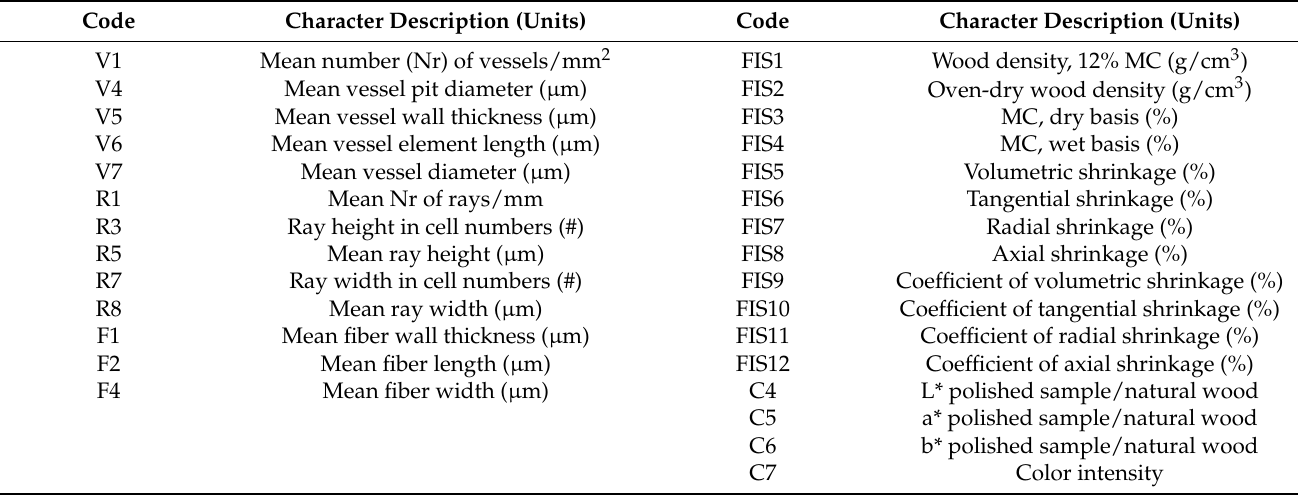
Table 2. Descriptions and codes of the anatomical and physical wood